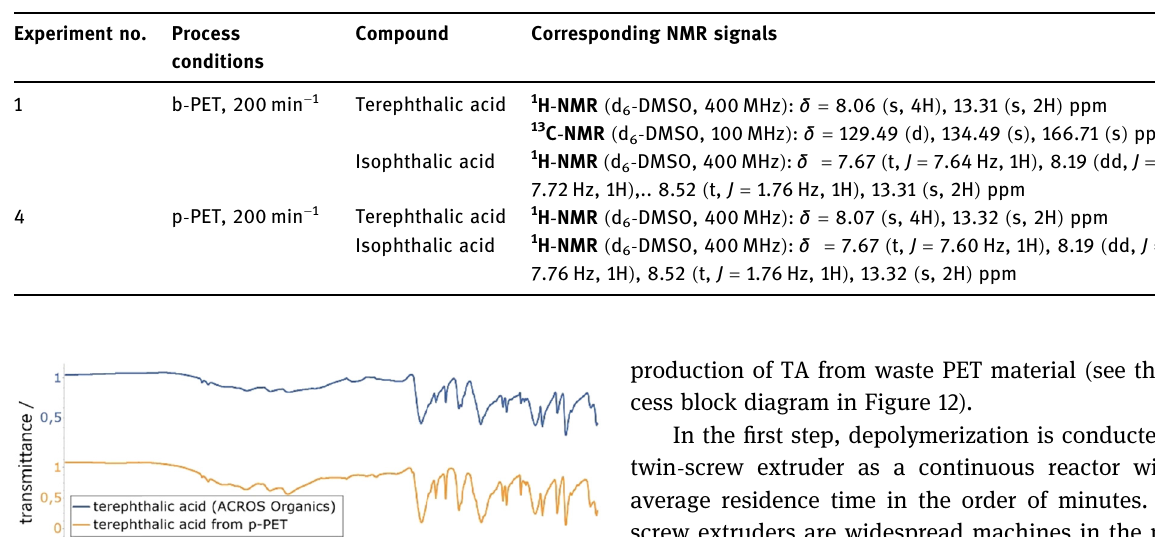
Table 2: Results of the 1 H - and 13 C - NMR - analysis of Experiments 1 and 4 ( cf. Table 1 )